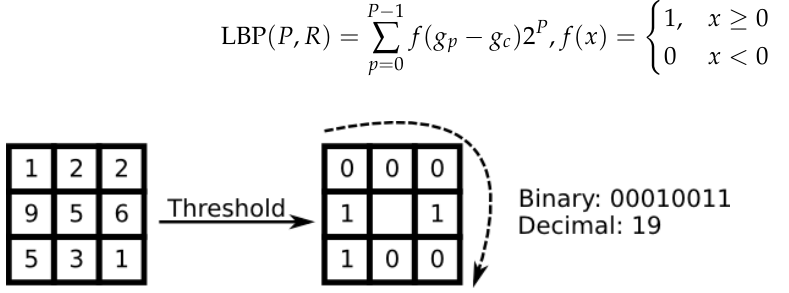
Figure 3. Illustration of the original LBP